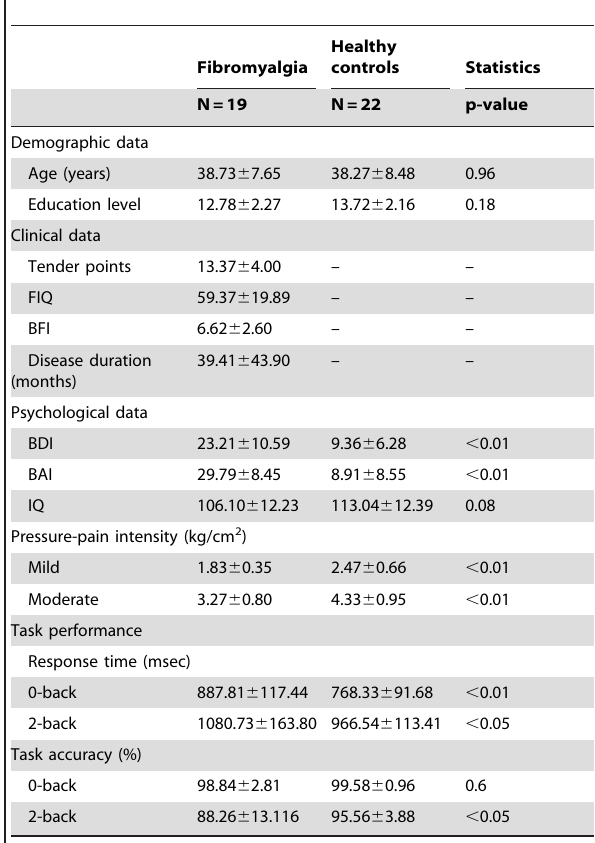
Table 1. Demographic and clinical information for fibromyalgia and control